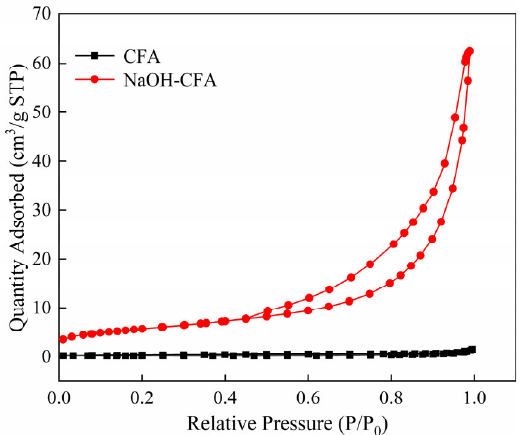
Figure 5. Relative quantity adsorbed of the CFA and NaOH ‐ CFA.